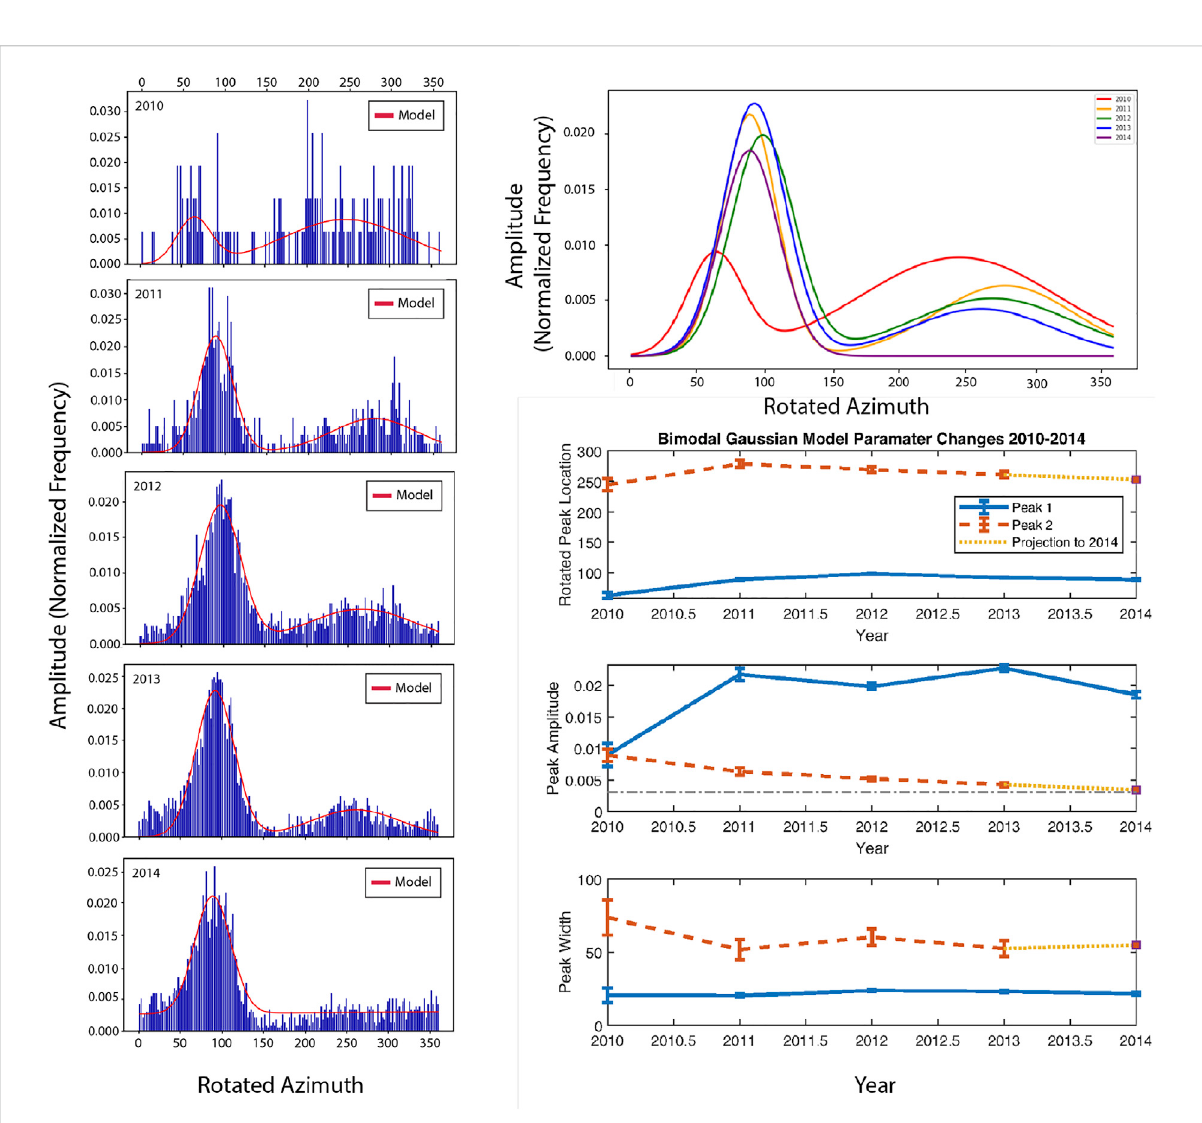
FIGURE 6 Annual polar histograms of the current or plume direction for NE005 (top), NW005 (bottom), COVIS (center panel), and the MEF ADCP at 21 m. Fromleftto right,all validdata fortheyears2010 through2014 areplotted.Foreachpolar histogram,North isatthetopand thebinsizeis2 ° .The NE currentmeterat5mabovebottom(NE005)shows anorth-south trendincurrentsconsistent throughout2010 – 2012.TheNWcurrentmeterat5m above bottom (NW005) shows a consistently southward current from 2011 to 2012. The MEF ADCP at 21 m above bottom shows a mixed, but dominantly southward trend in 2014 – 2015. In contrast, the COVIS plume data is predominantly of a northward inclination from 2011 to 2014. Both moorings are about 2 km north of COVIS. The MEF ADCP is south of COVIS in the central plain of MEF, about 60 m southwest of COVIS. See text for discussion of data